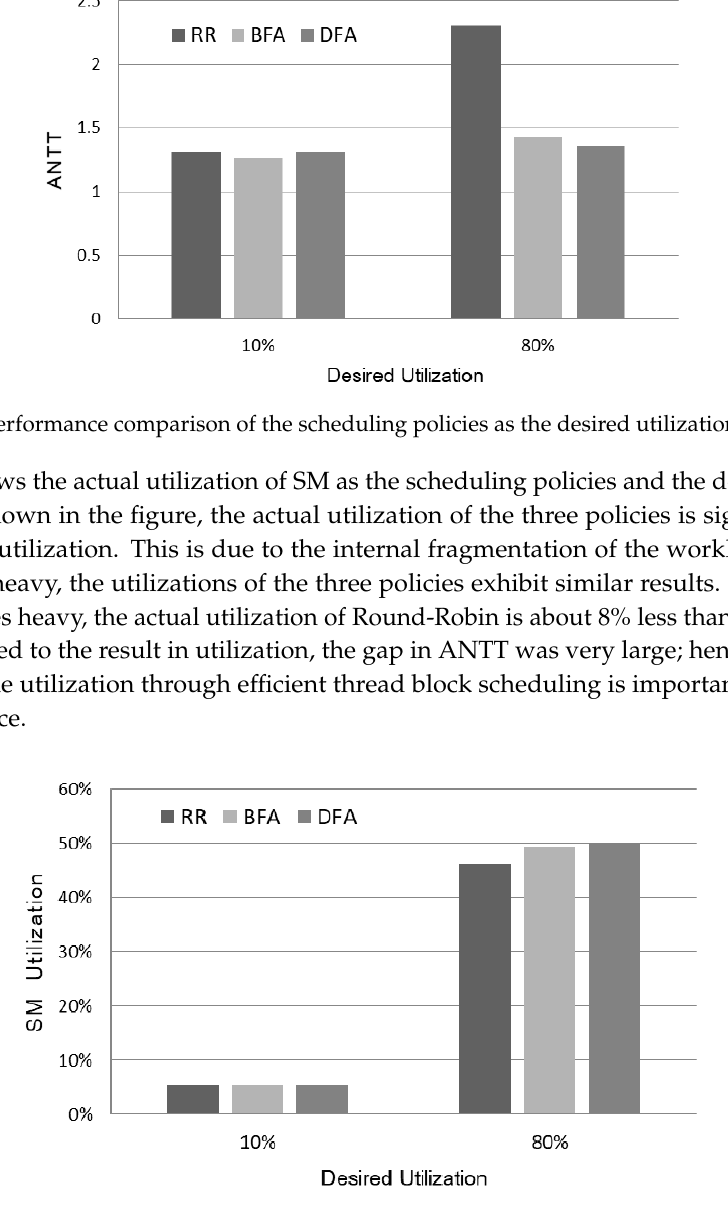
Figure 7. SM utilizations of the scheduling policies as the desired utilization is varied.